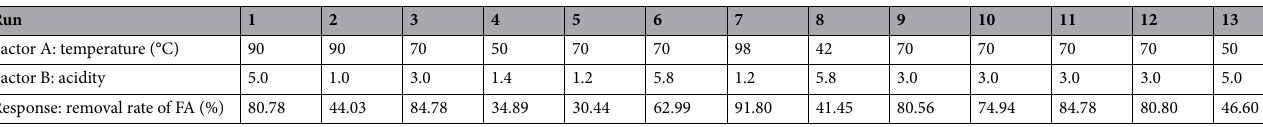
Table 5. CCD experimental design table.